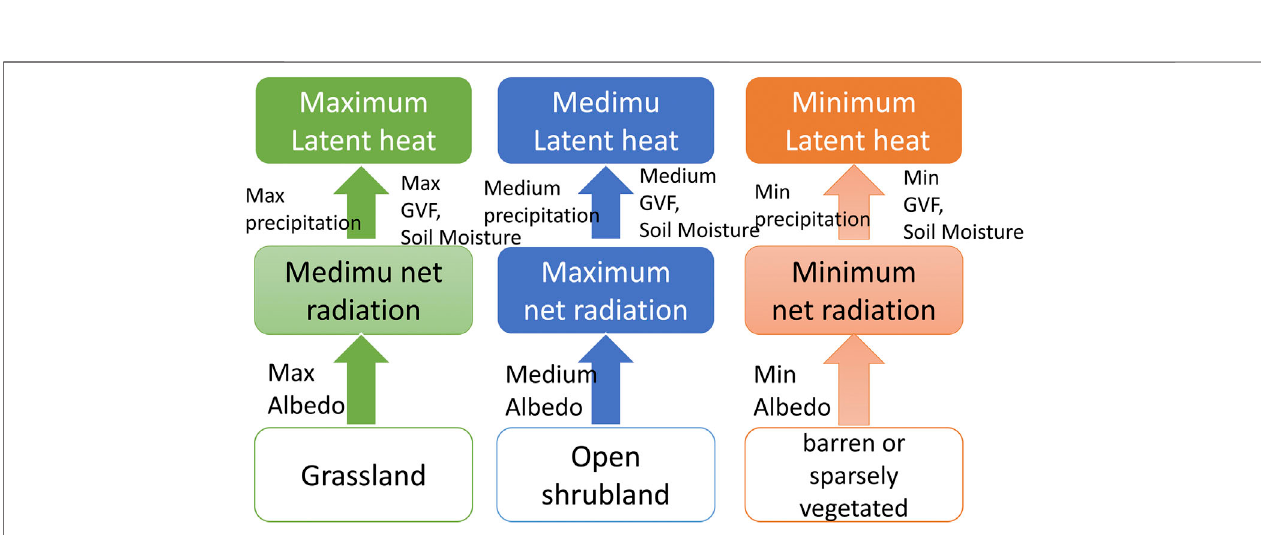
FIGURE 11 | The physical processes schematic diagram of water-energy cycle over different underlying surfaces.